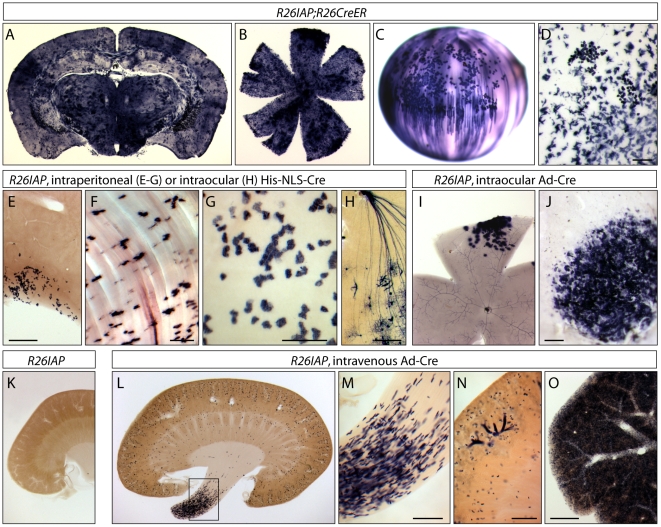

R26IAP is a sensitive reporter for Cre-mediated recombination in individual cells.(A–D) R26CreER;R26IAP mice either in the absence (A,B) or following intra-ocular injection (C,D) of 4HT show widespread Cre-mediated recombination in diverse cell types. A, brain; B, retina, C, lens, D, cornea. AP+ lens fiber and lens epithelial cells are seen in C. The overall frequency of AP-expressing cells in the brain and retina in the absence of 4HT is ∼0.01%. (E–G) R26IAP mice that received an IP injection of ∼184 µg of purified His-NLS-Cre protein show scattered Cre-mediated recombination only in epithelial cells lining the peritoneal cavity or in the muscle fibers of the abdominal wall immediately beneath the peritoneal surface. E, liver; F, abdominal wall; G, stomach. (H) R26IAP mice that received an intraocular injection of ∼7 µg of purified His-NLS-Cre protein at ∼P5 show scattered Cre-mediated in RGCs and in occasional astrocytes. RGC axons are converging on the optic nerve head at the top of the panel. (I,J) Retina (I) and cornea (J) following an intra-ocular injection of a replication defective adenovirus expressing Cre. Cre-mediated recombination and AP expression are confined to tissues near the injection site. In the retina, the compact appearance of the AP+ cells and the absence of AP+ axons suggests that most of the labeled cells are astrocytes and/or Muller glia. (K–O) Tissues from R26IAP mice in the absence (K) or following IV injection (L–O) of a replication defective adenovirus expressing Cre (Ad-Cre). K–N, kidney; O, liver. The boxed region of the renal pelvis in L is enlarged in M. N shows a region of renal cortex from a different mouse that received an IV injection of Ad-Cre in which Cre-mediated recombination was also observed in a subset of cortical tubules. Scale bars are: 1 mm for E and O; and 200 µm for D,F,G,H,J,M, and N.